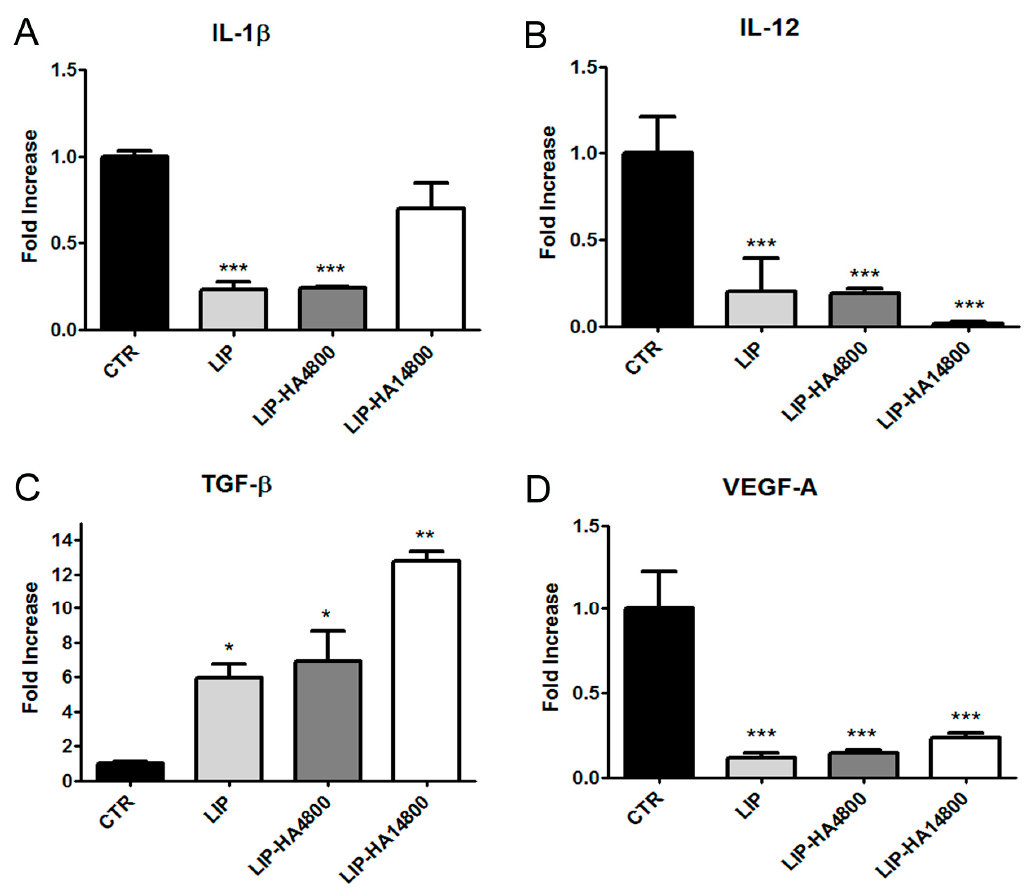
Figure 5. Analysis of transcript levels of IL-1 β ( A ), IL-12 ( B ), TGF- β 1 ( C ), and VEGF-A ( D ) in di ff erentiated THP-1 cells. Quantitative real-time PCR (qPCR) of mRNAs of THP-1 cells treated for 1 h with LIP, LIP-HA4800, and LIP-HA14800. mRNA values are expressed as fold increase over control values after normalization to the GAPDH gene expression and are the means ± SEM of three independent experiments. *, p < 0.05, **, p < 0.01, ***, p < 0.001 vs. CTR. 2.7. E ff ect of Liposomes on Monocytes and Neutrophils Derived From Blood of Healthy